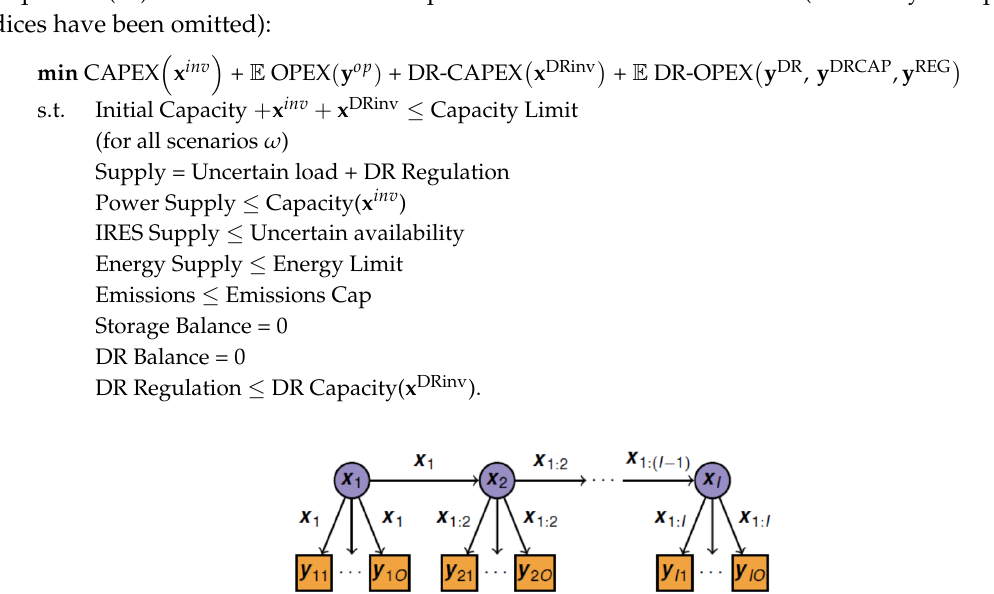
Figure 1. Investment periods in circles and operational periods in boxes. The investment variables x inv up to period l affect the next investment